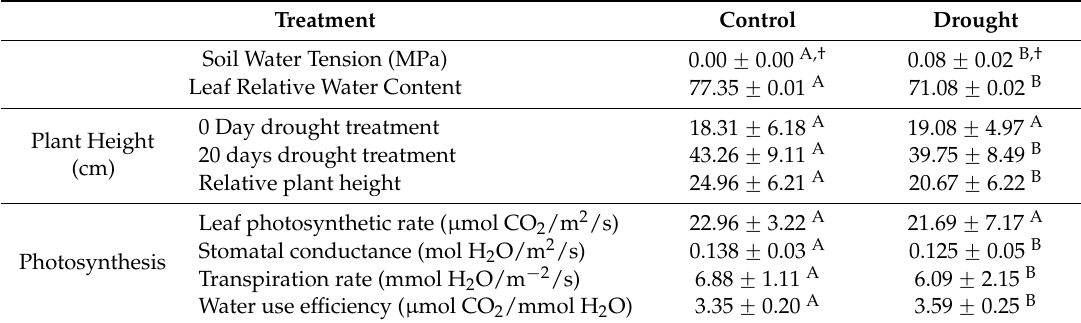
Table 1. Effects of drought treatments on physiological properties of